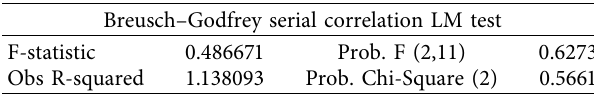
Table 8: Autocorrelation test results of residual sequence.